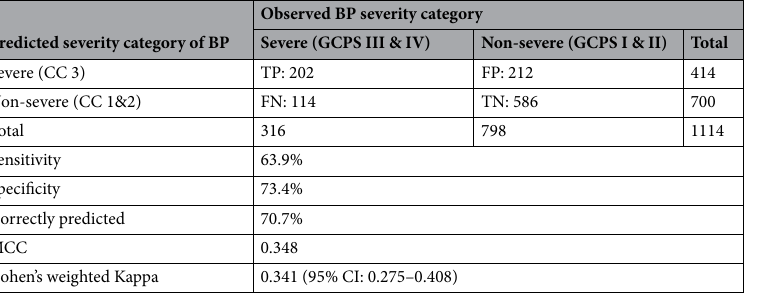
Table 4. Sensitivity analysis with participants insured against sick leave. GCPS Graded chronic pain grade 27 based on a self-questionnaire at enrolment, CC Chronicity class 36 based on administrative claim data, TP True positive were actual severe BP cases that were correctly predicted as severe, TN True negative were actual non- severe BP cases that were correctly predicted as non-severe, FP False positive were actual non-severe cases of BP that were wrongly predicted as severe, FN False negative were actual severe BP cases that were incorrectly predicted as